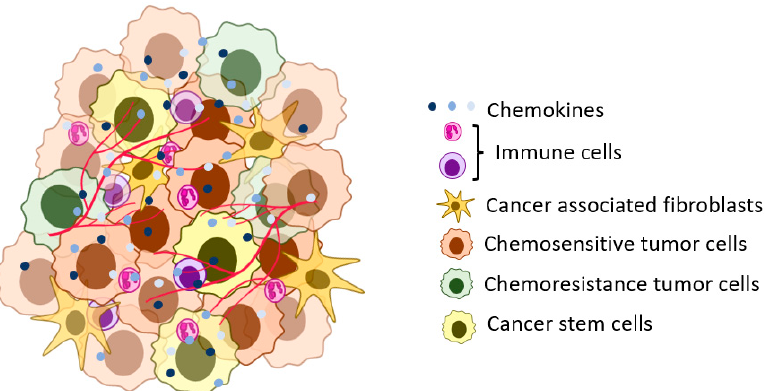
Figure 1. A representation of the solid tumor microenvironment. The tumor cells in the tumor microenvironment can have different phenotypic and genotypic characteristics (heterogeneity) in niche areas of the tumor. The tumor cells interact with stromal and other tumor cells using signaling pathways, including chemokine ligands.